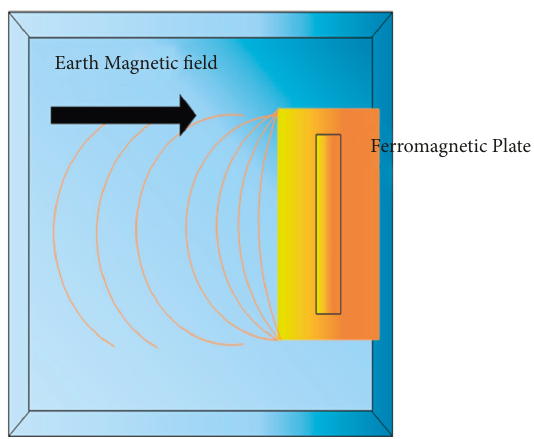
Figure 4: Distortion due to a ferromagnetic